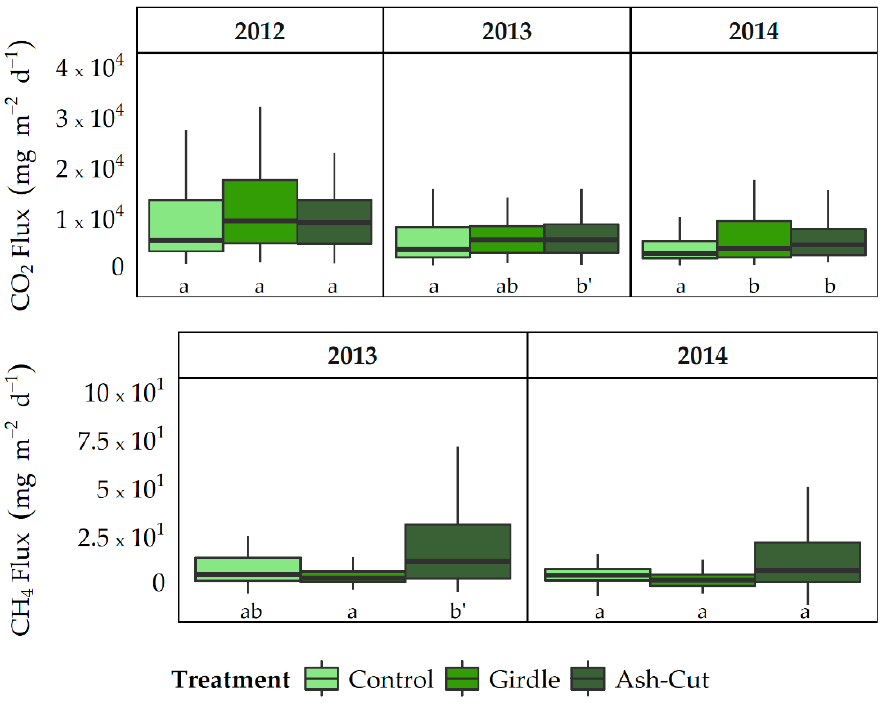
Figure 4. ( A ) Soil CO 2 flux for each treatment during 2012, 2013, and 2014; ( B ) Soil CH 4 flux for each treatment during 2013 and 2014. Significant between-treatment differences in mean flux at p > 0.05 are indicated by (a) and (b), where ( ′ ) indicates detection of marginally significant between-treatment mean differences at p < 0.1. Boxplot lines represent median, 25%, and 75% quantiles, while whiskers represent quantiles ± 1.5 ∙ interquantile range, respectively [58].